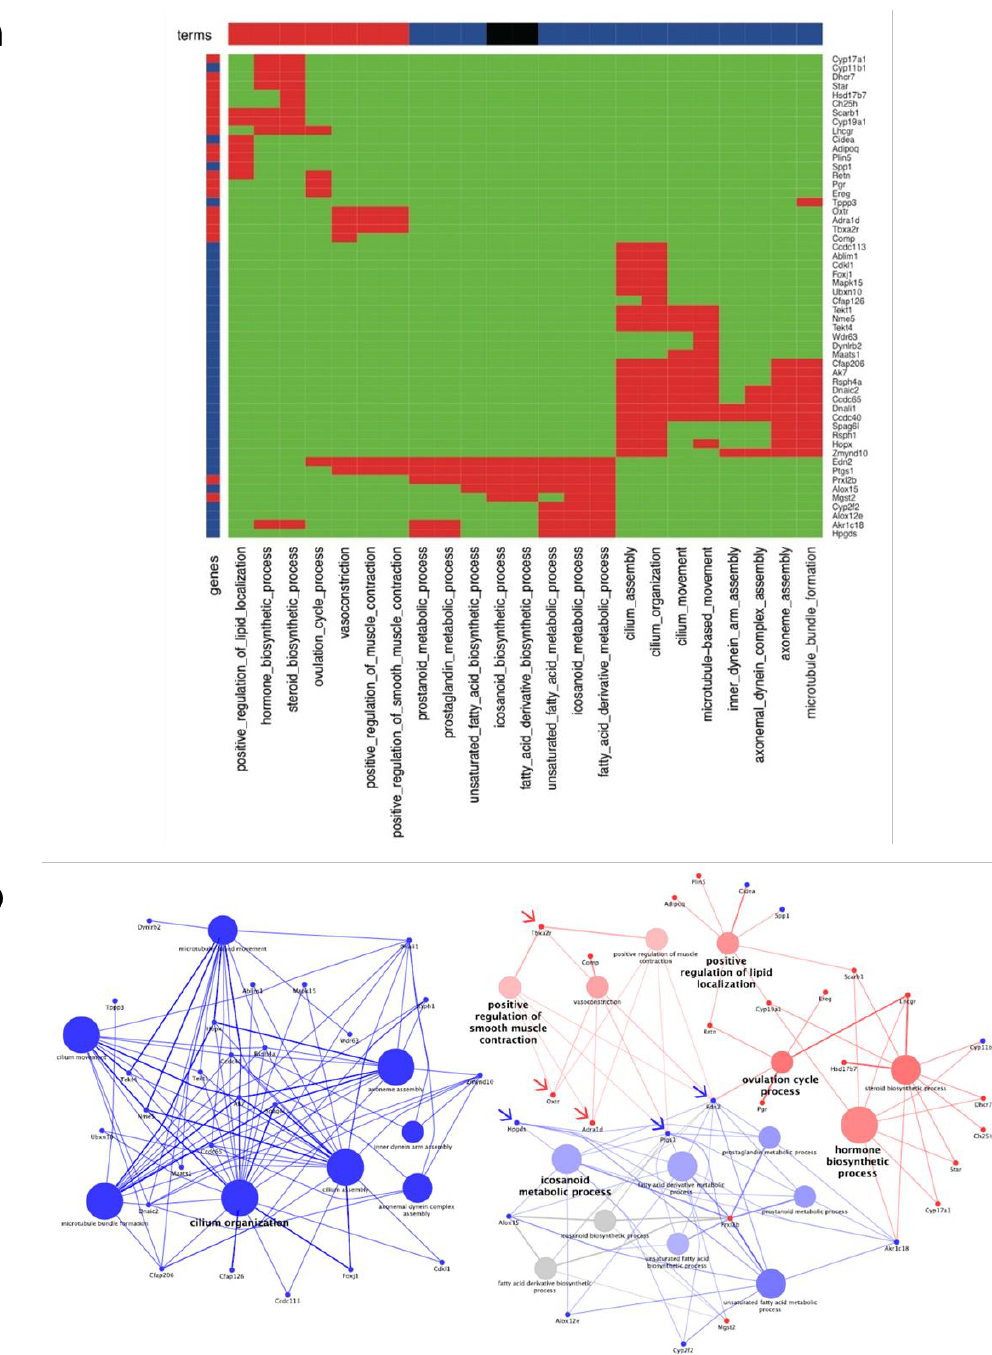
Figure 5. Up/downregulated genes based on an absolute fold-change of more than 4 in RGMc-treated ovaries. ( a ) Heatmap based on a binary code for significantly enriched terms and up/downregulated genes in RGMc-treated ovaries. Blue and red in the top and side bars represent upregulated and downregulated terms in RGMc-treated ovaries, respectively. Black in the top and side bars represents nonsatisfied terms with higher than 60% enrichment for up/downregulated genes. Red and green in the heatmap represent the presence and absence of the gene, respectively. ( b ) Network between significantly enriched terms and up/downregulated genes (fold-change > 4). Blue and red represent upregulated and downregulated genes/terms in RGMc-treated ovaries, respectively. Gray represents nonsatisfied terms with higher than 60% enrichment for up/downregulated genes. Blue and red arrows indicate target genes for validation that were upregulated and downregulated upon RGMc treatment, respectively.